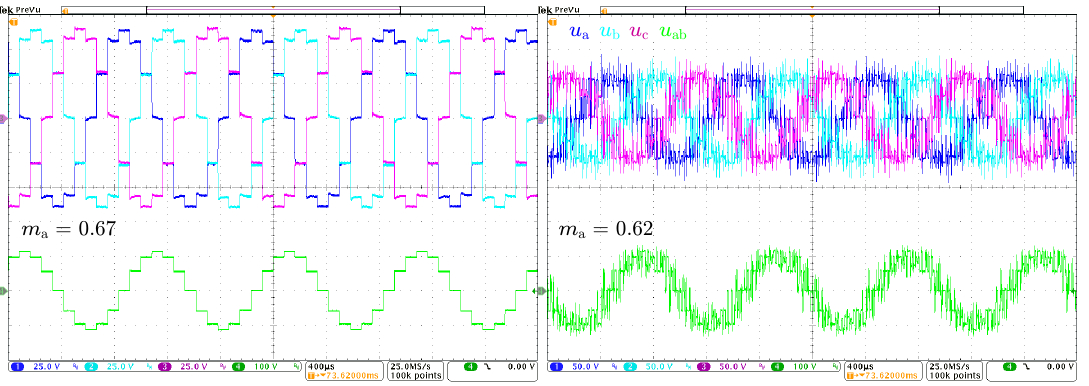
Figure 14. Output voltages for CQ-PAM ( left ) and space-vector pulse width modulation (SVPWM) ( right )